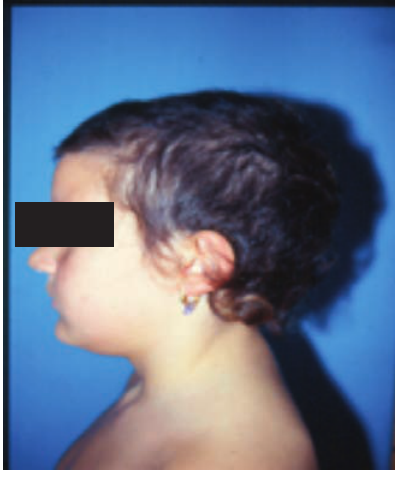
Figure 1. Scalp with inhomogeneous distri- bution.